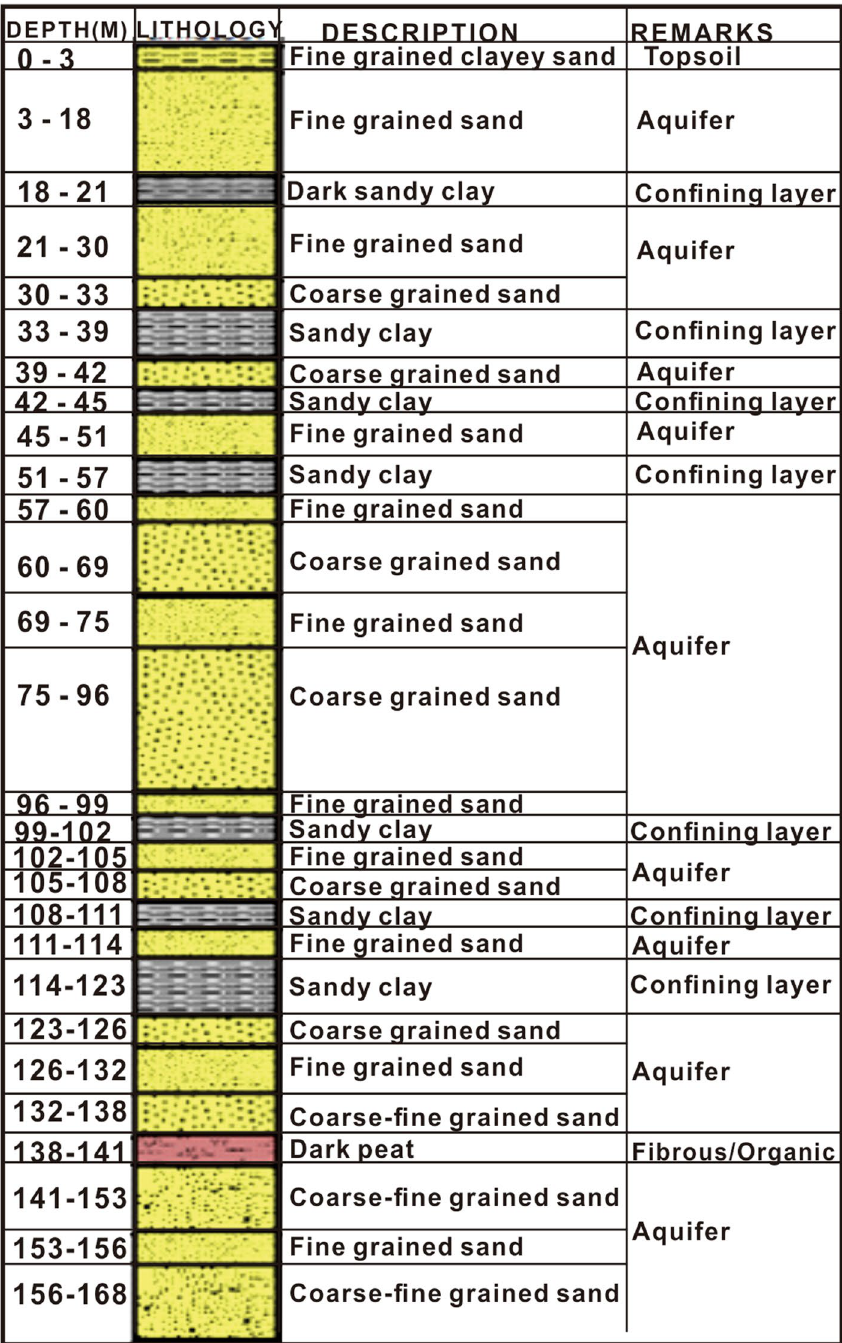
Fig. 4 Borehole log of a well drilled through the coastal plain sands in the study